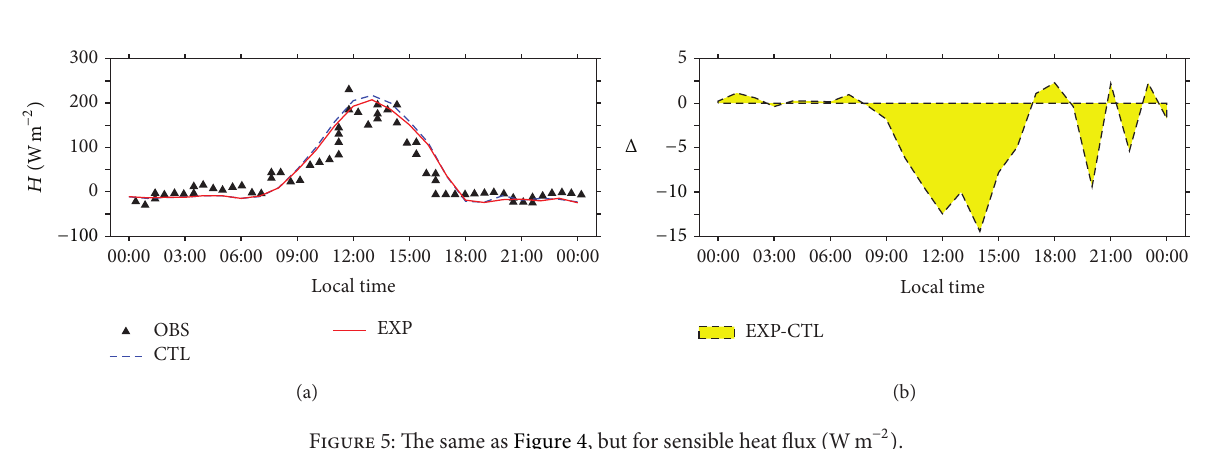
Figure 4: (a) Diurnal variation of the friction velocity ( ms −1 ) simulated by the CTL run (blue dashed line) and the EXP run (red solid line) at a horizontal resolution of 1km from 0000 LST 28 February to 0000 LST 1 March 2001, and their comparisons with the observation (triangle). (b) Differences of simulated friction velocity ( ms −1 ) between the EXP run and the CTL run.